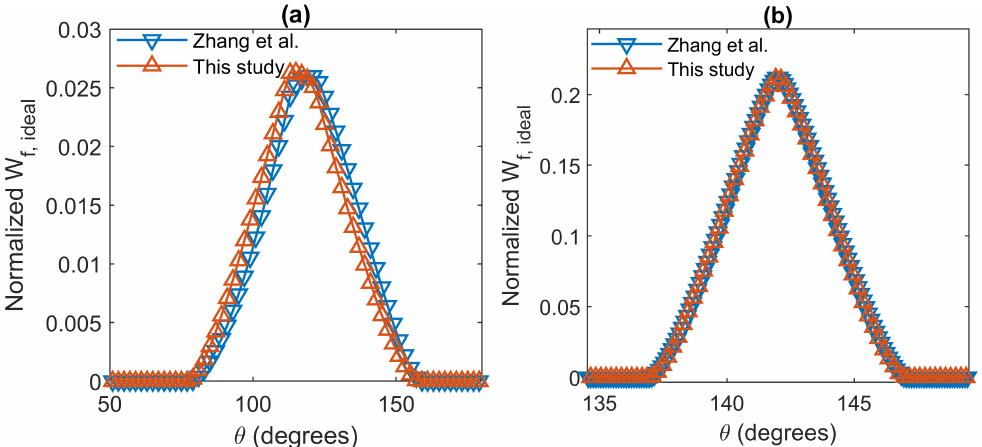
Figure 7. Comparison between the normalized W f , ideal using different methods, θ is the scattering angle [19]. ( a ): Eco-BB. ( b )